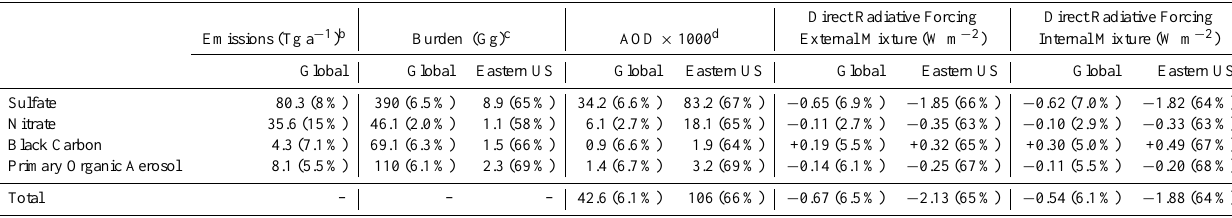
Table 1. Aerosol direct radiative forcing from global and US anthropogenic sources (2010) a .